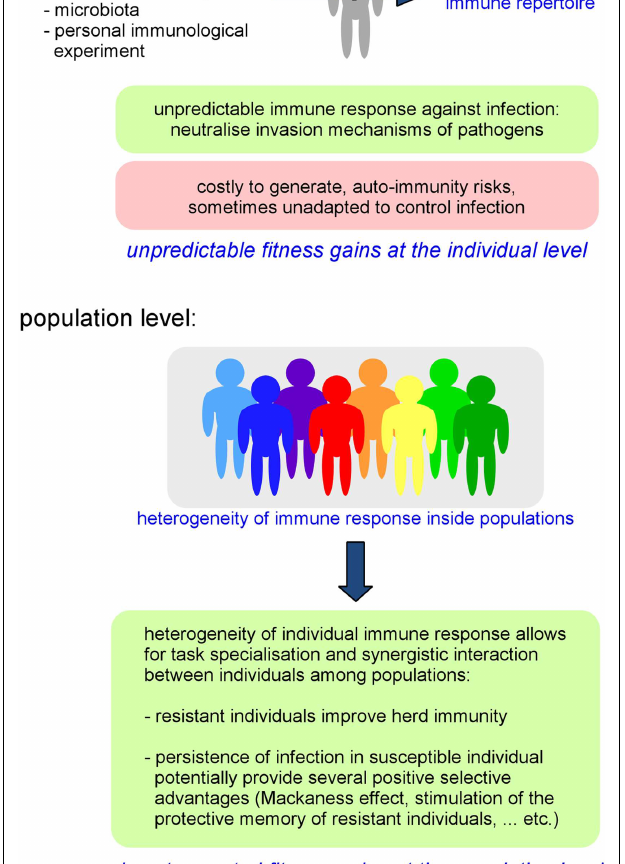
FIGURE 1 | Fitness gains at the individual and population level generated by theAIS-induced private immune repertoire